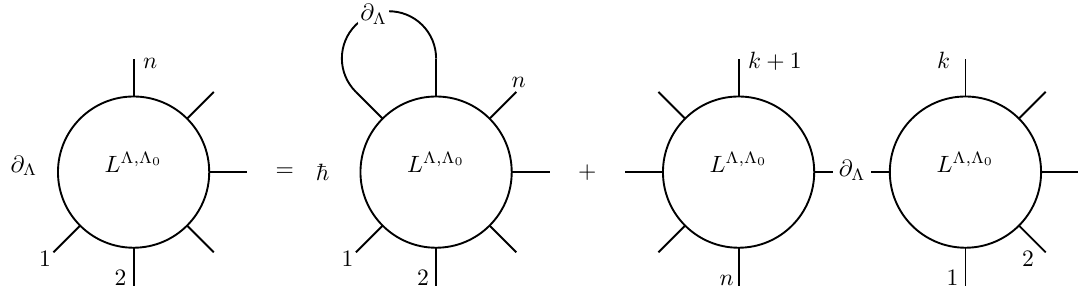
Figure 1 . Schematic depiction of the flow equations for n -point correlation functions. where the sum in the second line runs over all disjoint subsets I and J . The flow equations are depicted in figure 1: the first term on the right-hand side is a loop correction that connects two external legs of a higher n -point correlation function with a propagator, while the second term connects two lower n -point functions with a